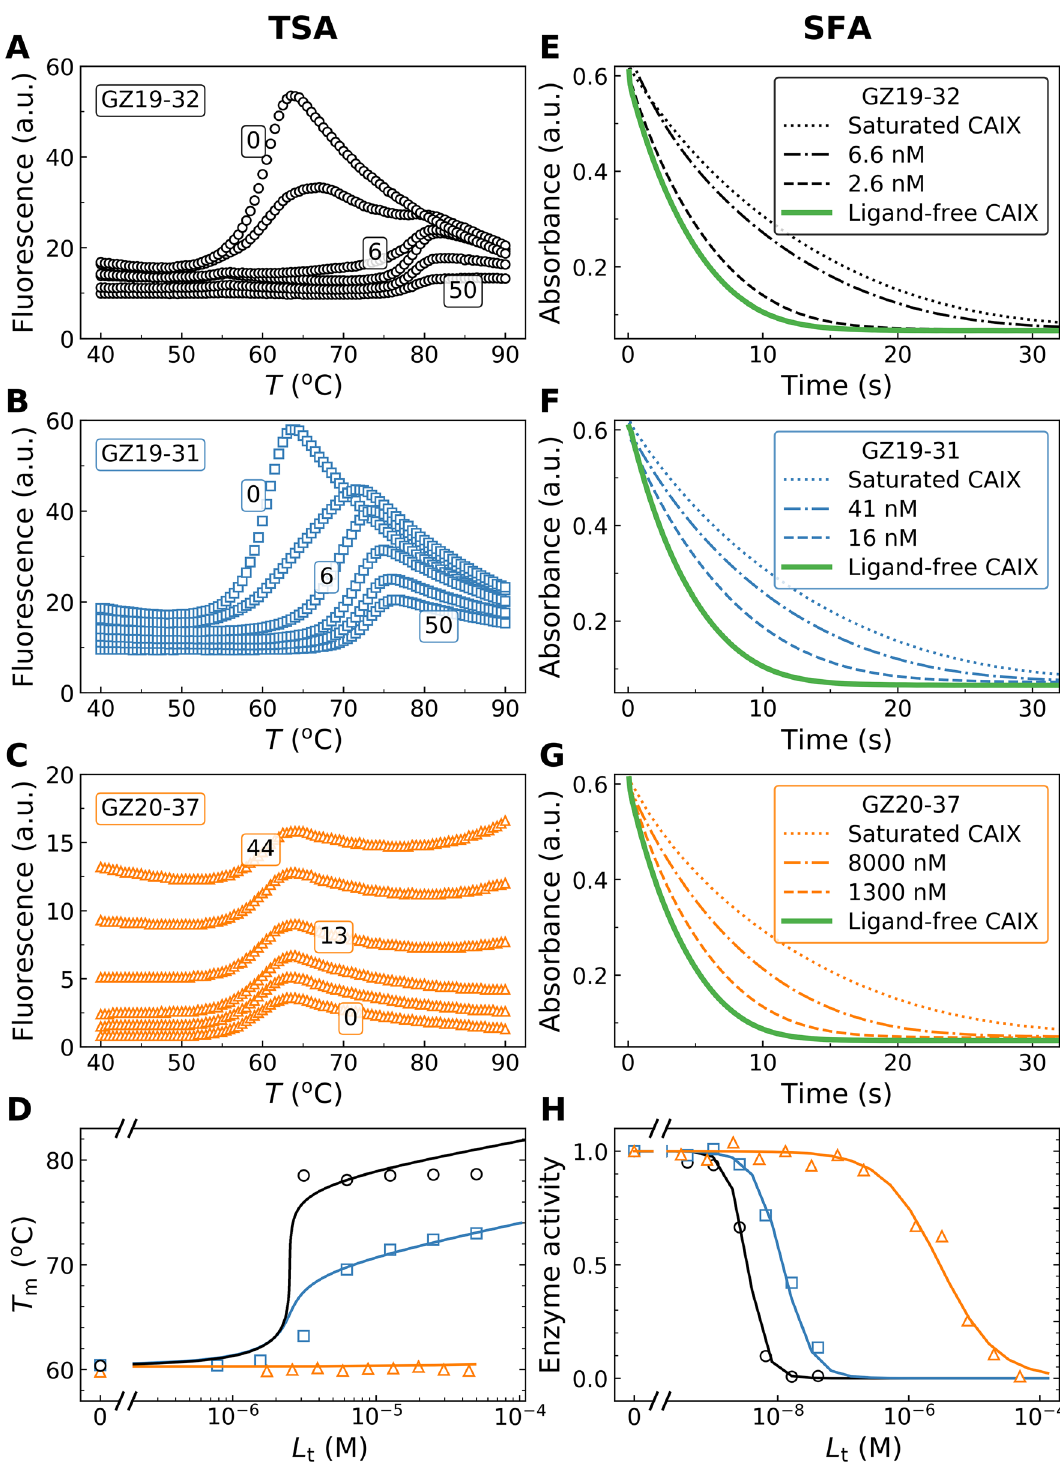
Figure 2. Determination of fluorescein-labeled compound affinities for the catalytic domain of recombinant human CAIX by the TSA (left panels) and the SFA (right panels). The upper three rows show the raw binding data for GZ19-32 (black), GZ19-31 (blue), and GZ20-37 (orange). ( A , B , and C ) The fluorescence profiles upon protein thermal melting. ( E , F , and G ) The absorbance decrease due to pH indicator color change upon acidification by CAIX in the SFA assay. The ‘ligand saturated CAIX’ dotted line matches the line observed for the spontaneous hydration of CO 2 . The bottom panels show the dosing curves by TSA ( D ) and SFA ( H ). SFA is limited to the affinity which is close to the concentration of CA used in the enzymatic assay. Therefore, only the TSA yielded accurate K d values in the pM affinity